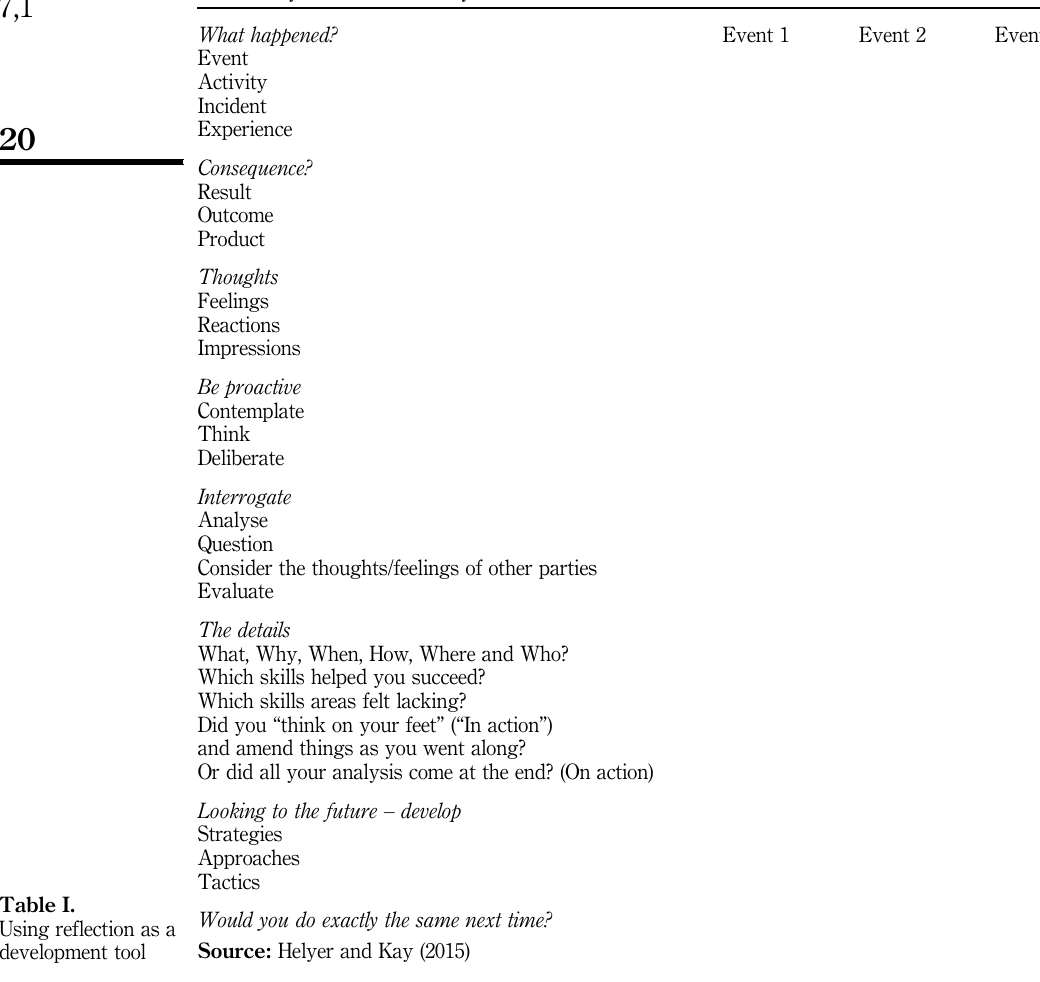
Table I. Using reflection as a development